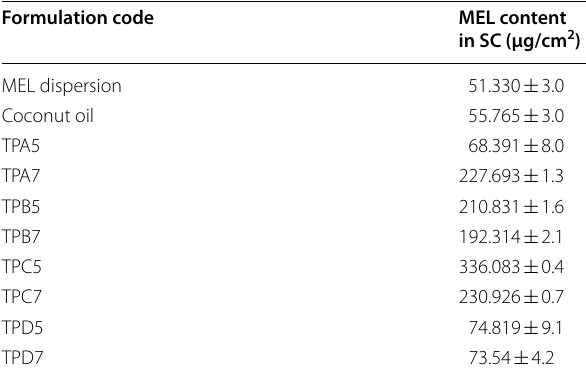
Table 3 MEL deposition in stratum corneum (SC) from different formulae Formulation